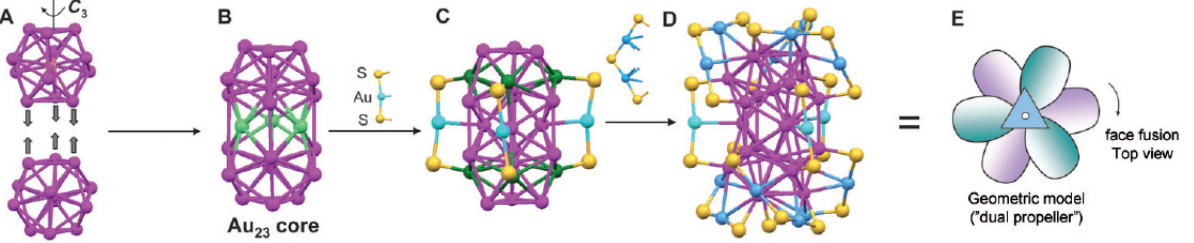
Figure 8. Anatory of Au ( B , C ) side and top views of Au kernel; ( F ) overall framework of Au